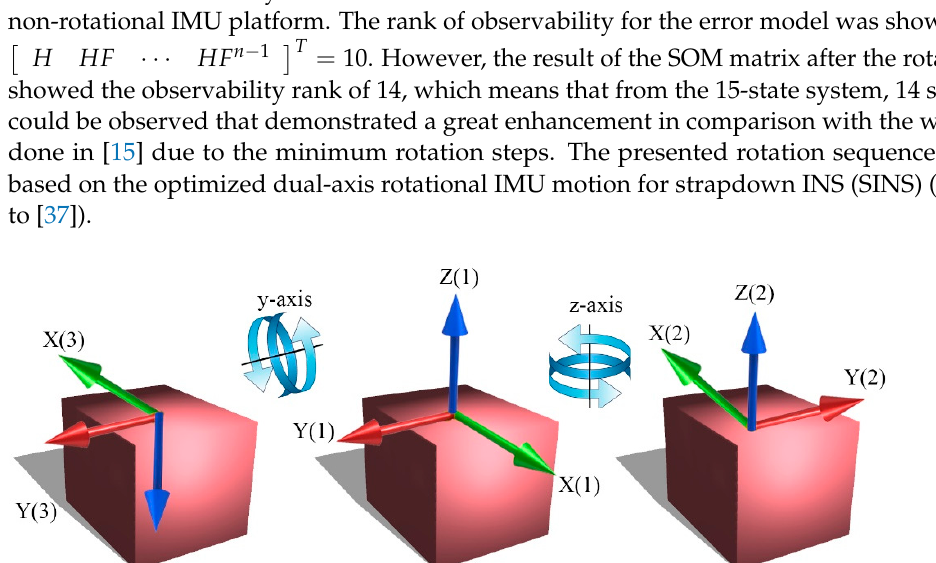
Table 1. IMU rotation sequences.